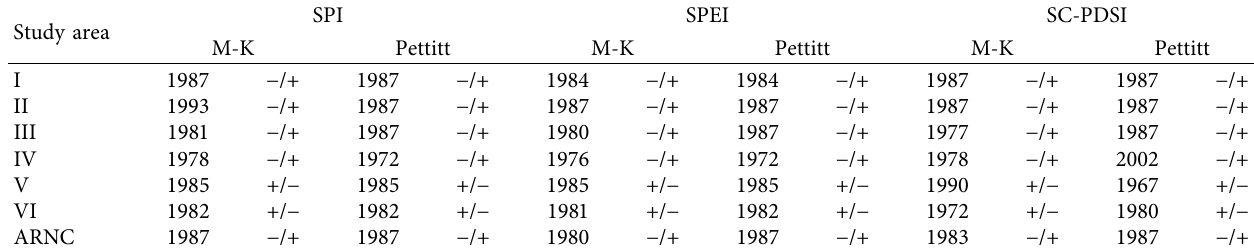
Table 5: Analysis of the catastrophe points of the SPI, SPEI, and